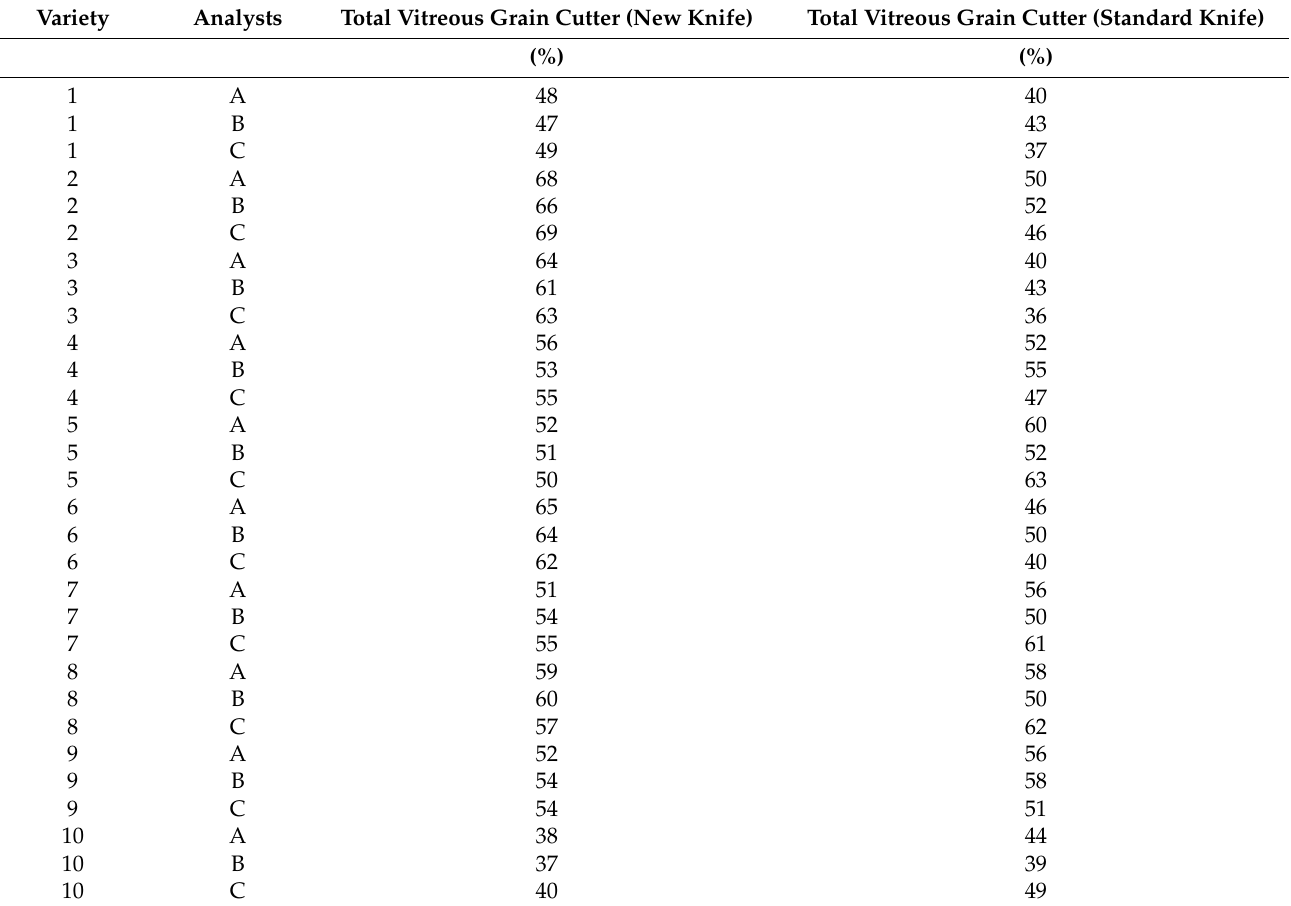
Figure 13. Cuts of the 10 wheat varieties with improved Pohl’s grain cutter (new knife). Table 2. The degree of the vitreous of the wheat sample determined by